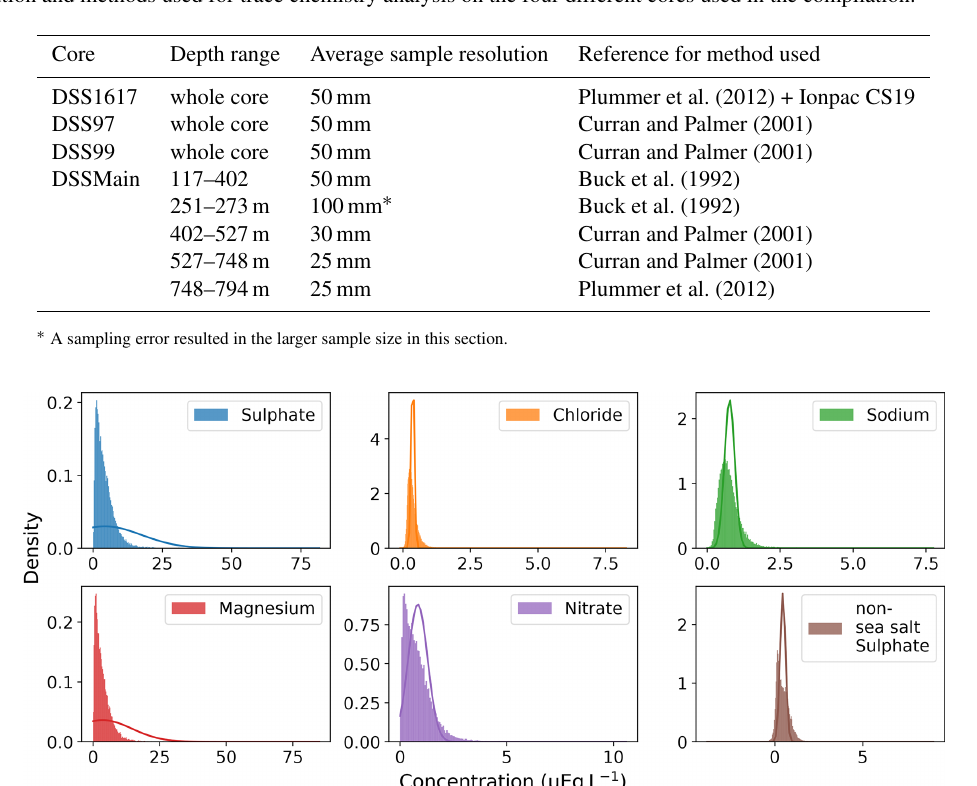
Table 3. Resolution and methods used for trace chemistry analysis on the four different cores used in the compilation.